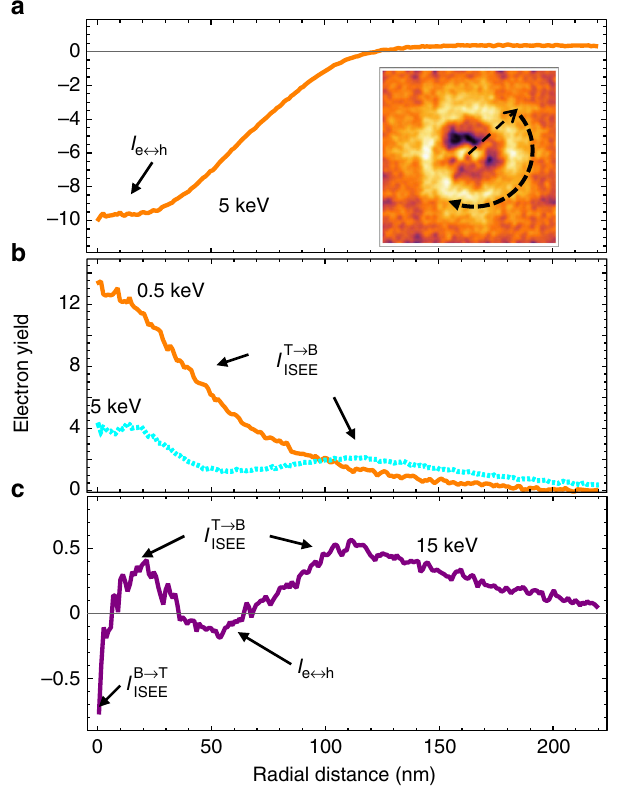
Fig. 6 Radial distributions of EBIC. a Radial plot of the azimuthally averaged electron beam-induced current (EBIC) electron yield for a device in the off- state measured at 5 keV with the current mostly attributed to electron – hole pair separation and (inset) pictorial depiction of azimuthal averaging of an EBIC map. b Radial plot of the EBIC electron yield in the on state at low energy (0.5 keV) and an intermediate energy (5 keV) showing a signal dominated by ISEE from top to bottom but with an increasing contribution from the other currents. c Radial plot in the EBIC electron yield in the on state at 15 keV showing different regions with different dominant currents (indicated by current label and arrows) leading to a radially oscillating